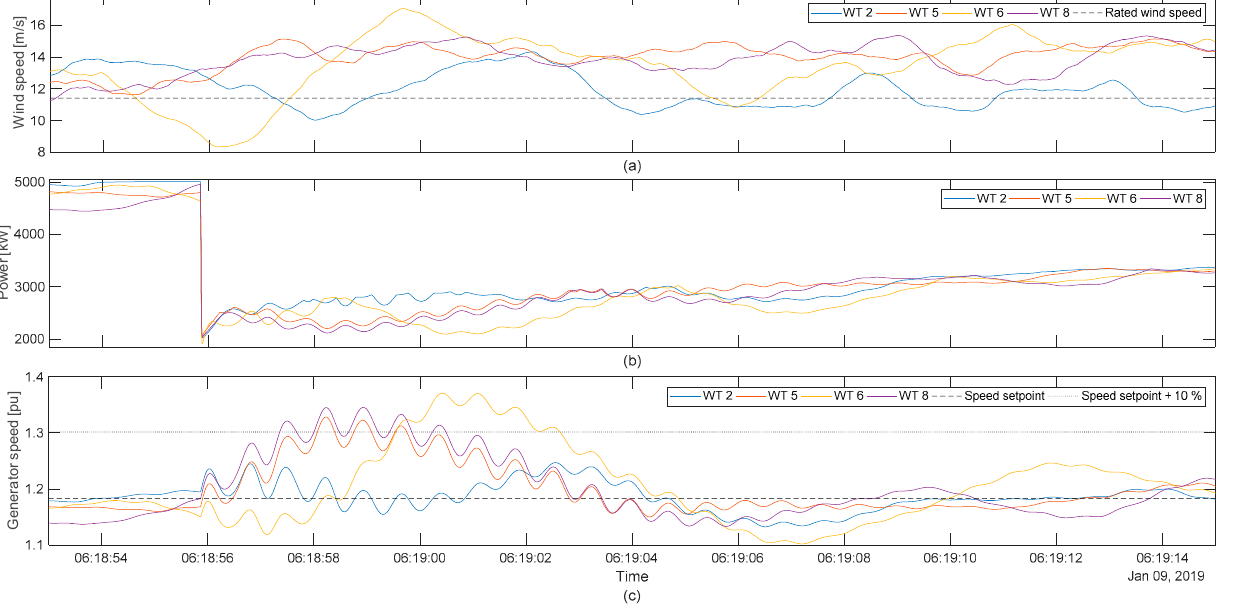
Figure 10. Simulation results of scenario I for four WTs: ( a ) Wind speed and rated wind speed; ( b ) Generator power; ( c ) generator speed, speed setpoint, and overspeed threshold. The time axis of ( c ) is valid for the above subplots as well.